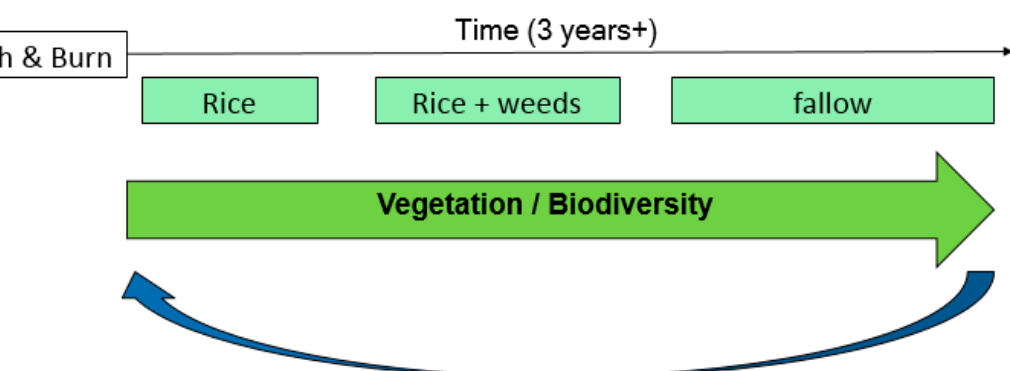
Figure 5. Model description: landscape patches’ cycle of swidden agriculture.